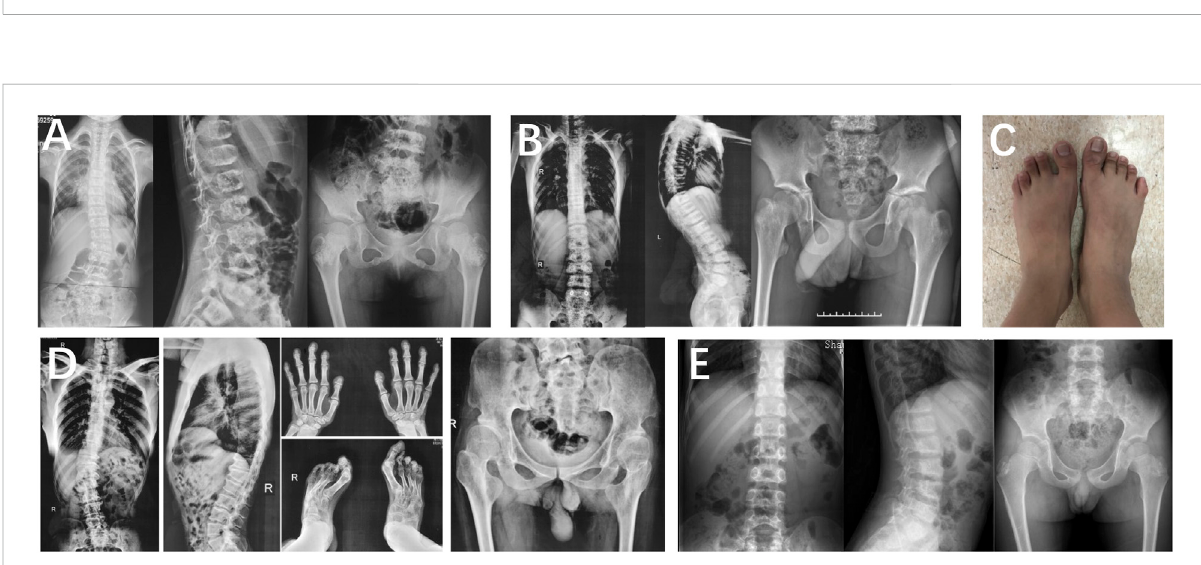
FIGURE 3 Photographsandradiographsoffamilies1and2withTRPV4-relatedskeletaldysplasia. (A) Radiographsofthespineandpelvisofproband1( Ⅱ -1) infamily1.Mildscoliosis,ovoidvertebralbodies,androughedgesofthevertebralbodiesweresigni fi cantinthespine.Disorganizationofmetaphysis was in the pelvis. (B,C) Radiographs of the spine and pelvis (B) , and photographs of feet (C) of proband 2 ( Ⅲ -1) in family 2. (B) Rough edges of the vertebralbodiesandlumbarlordosiswerevisibleinthespine.Disorganizationofthemetaphysisandshorteningofthefemoralneckwereinthe pelvis. (C) Fourthmetatarsaldysplasiawasintheleftfoot. (D) Radiographsofhands,spine,pelvis,andfeetofproband2 ’ sfather( Ⅱ -1).Mildcontracture